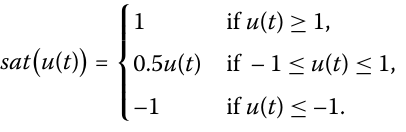
shore and earthquake engineering. It has been shown that the FHPS possesses chaotic and oscillatory motions [35]. The dynamic behavior of FHPS is governed by the following equations and with α = 0.1 is illustrated in Fig. 5.